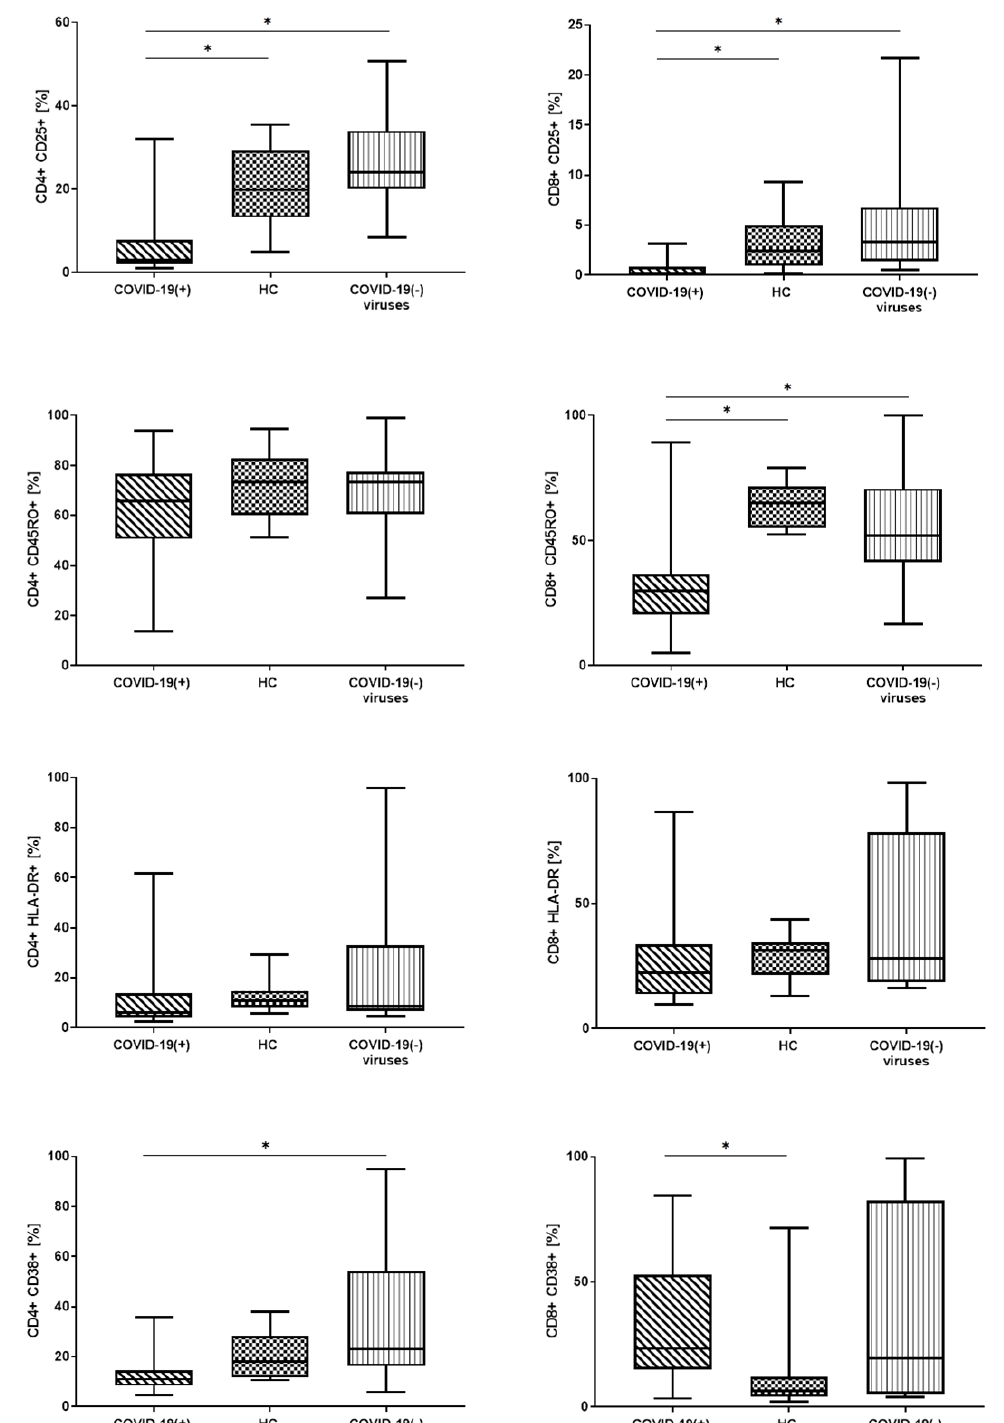
Figure 1. The differences of lymphocyte T subtypes with expression of activation markers CD25, CD45RO, CD38 and HLA-DR between patients: with positive COVID-19 test (COVID-19(+)), control group (HC), and group with other virus infections with negative COVID-19 test (COVID-19(−) virus). Graphs show the median values (Min–Max), * p < 0.05.